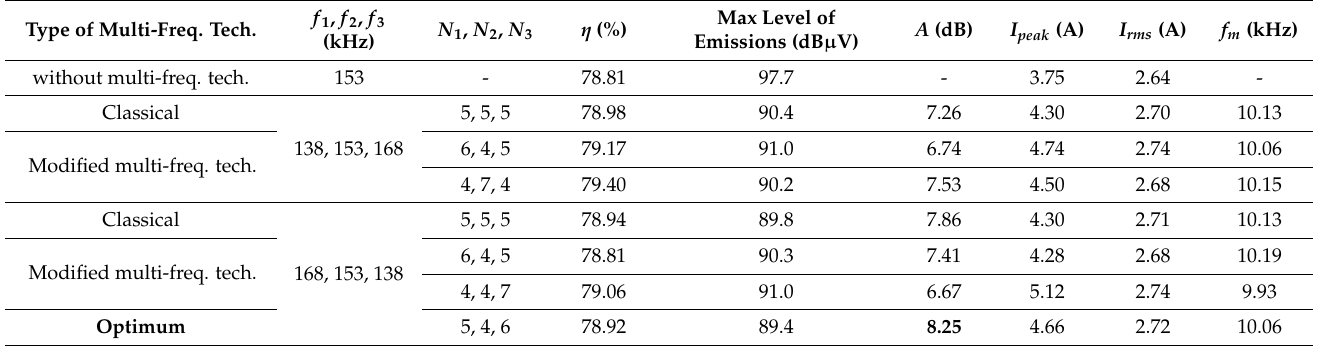
Table 2. The performance characteristics of the wireless battery charger without the multi-switching- frequency technique and with the technique (with different combinations of a number of pulses and the order of the switching frequencies). The load resistance is 18 Ω , and the coils were aligned perfectly.